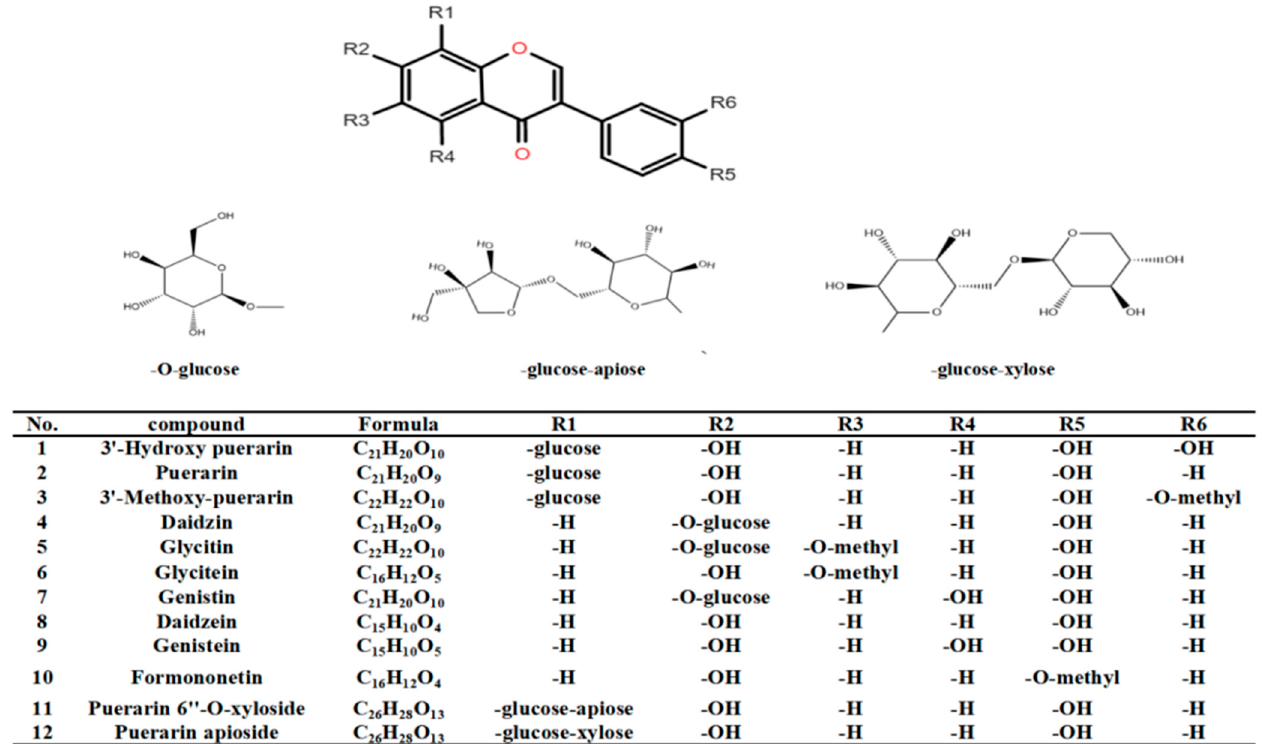
Figure 1. Chemical structures of the 12 isoflavone compounds.